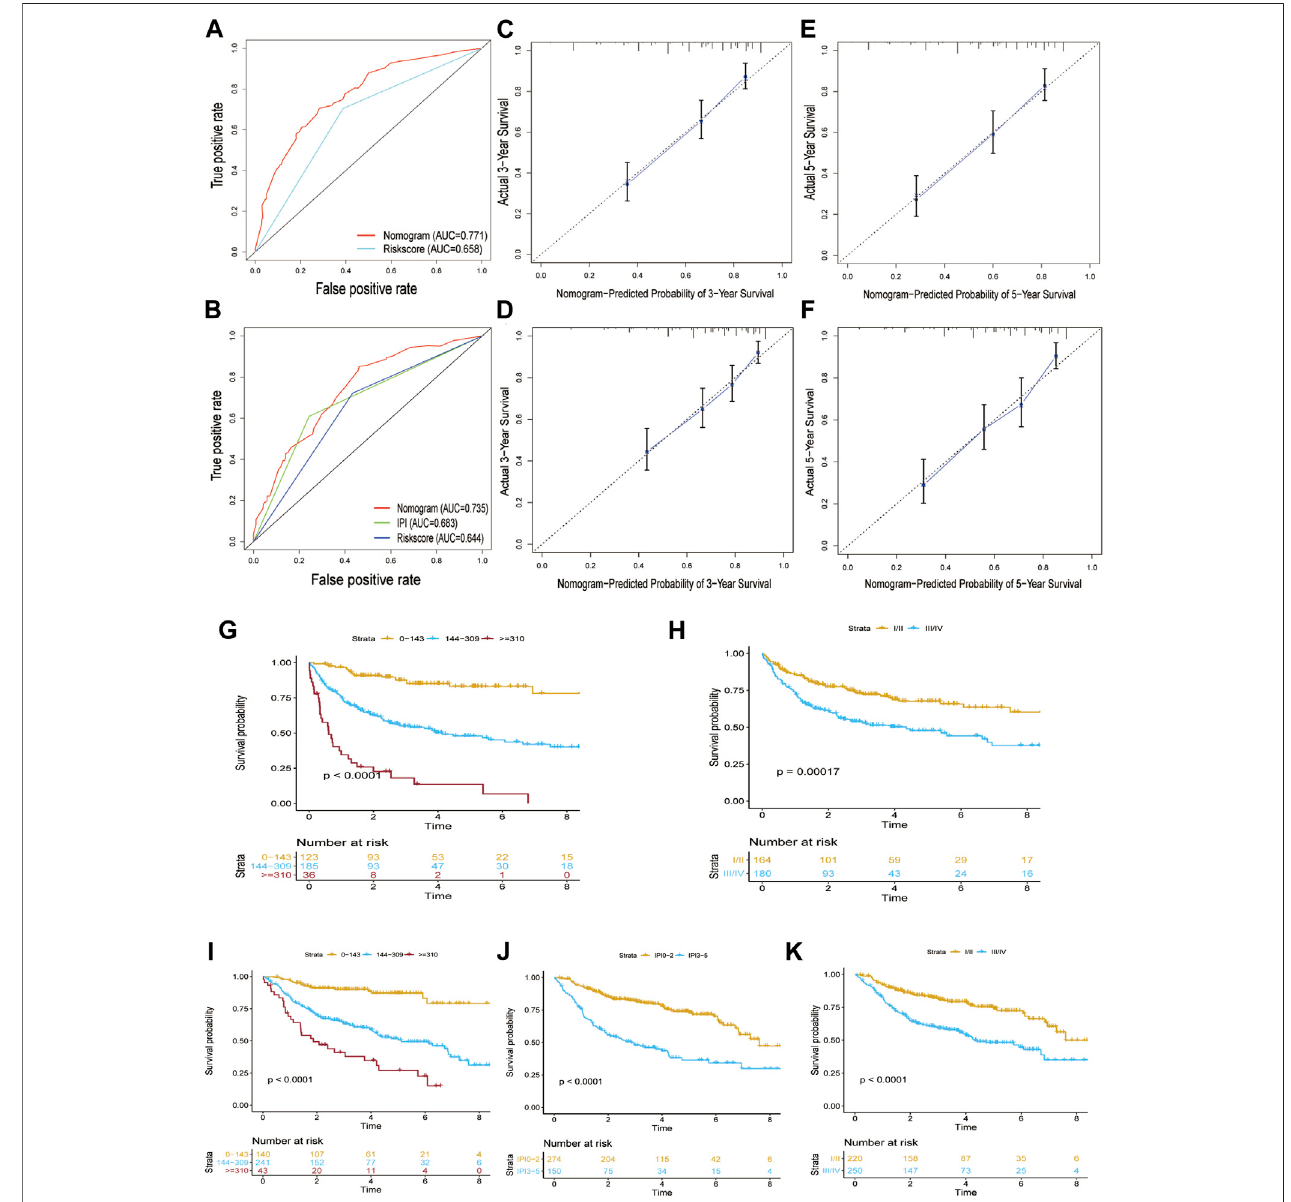
FIGURE 7 | Veri fi cation of the performance of the nomogram model. (A) Area under the ROC curve at 3 years was used to assess the prognostic accuracy of the nomogramintheGSE10846dataset. (B) AreaundertheROCcurveat3 yearswasusedtoassesstheprognosticaccuracyofthenomogramintheGSE31312dataset. (C) Calibrationcurvesofthenomograminpredictionofthe3-yearOSintheGSE10846dataset. (D) Calibrationcurvesofthenomogram inpredictionofthe3-yearOSin the GSE31312 dataset. (E) Calibration curves ofthenomograminprediction ofthe5-year OSintheGSE10846 dataset. (F) Calibration curves ofthenomogram in prediction of the 5-year OS in the GSE31312 dataset. (G) Kaplan – Meier curves showing the survival difference between different nomogram score groups in the GSE10846 dataset. (H) Kaplan – Meier curves showing the survival difference between different stages in the GSE10846 dataset. (I) Kaplan – Meier curves showing the survival difference between different nomogram score groups in the GSE31312 dataset. (J) Kaplan – Meier curves showing the survival difference between different IPI score groups in the GSE31312 dataset. (K) Kaplan – Meier curves showing the survival difference between different stages in the GSE31312 dataset.